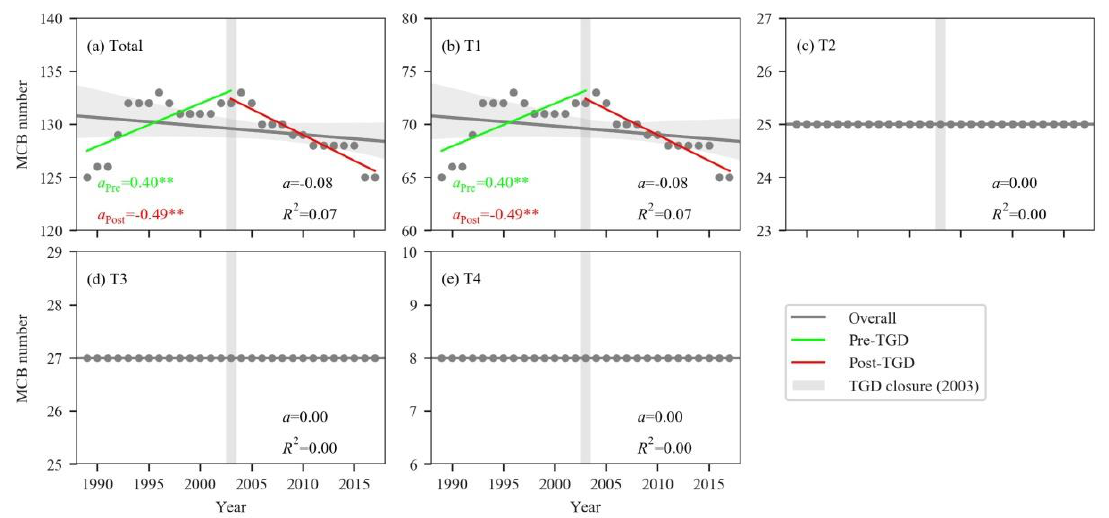
Figure 7. Temporal dynamics of MCB number for different groups of MCBs: ( a ) Total MCBs, ( b ) T1 MCBs, ( c ) T2 MCBs, ( d ) T3 MCBs, and ( e ) T4 MCBs. The regression parameters a and R2 stand for regression slope and coefficient of determination, respectively. Slope value with “*” and “**” indicate the corresponding p -value < 0.05 and < 0.01, respectively.